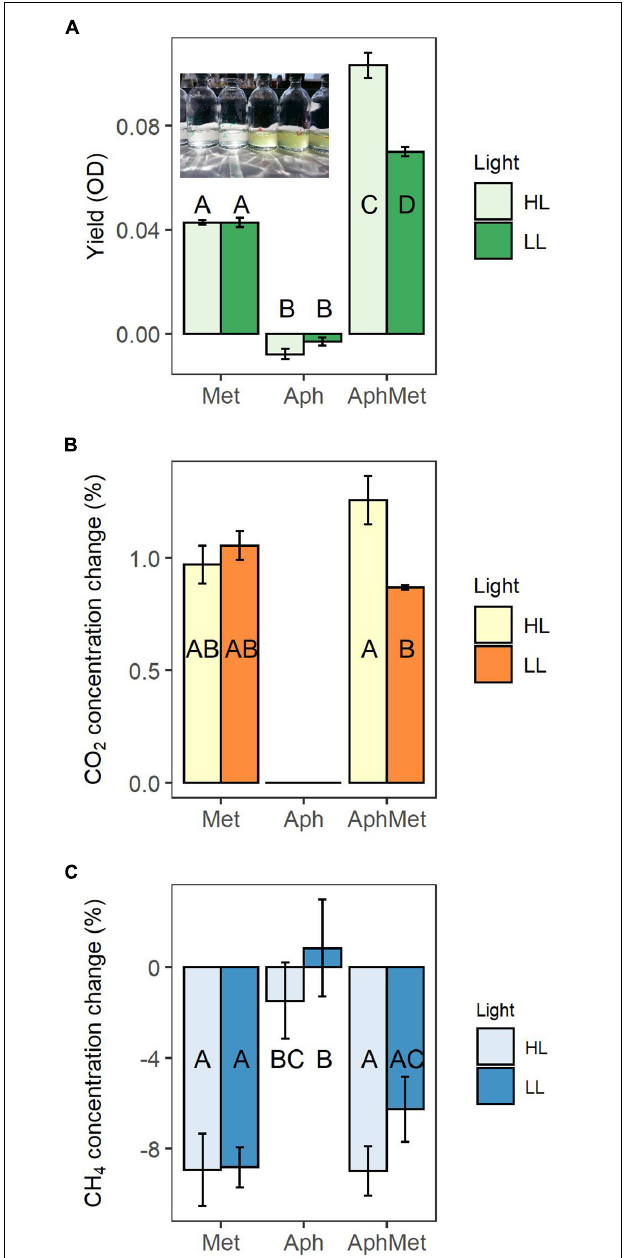
FIGURE 3 | Yield of mono- and co-cultures expressed through optical density (OD), measured at 750 nm (A) , and changes in methane (B) and carbon dioxide (C) concentrations in these incubations. The inset picture represents cultures of Aphanizomenon only (left) and Aphanizomenon with Methylosinus (right) after 12 days. Bars represent the mean ± standard error ( n = 5 for each treatment). Met, Methylosinus ; Aph, Aphanizomenon ; AphMet, mixture of Aphanizomenon and Methylosinus ; HL, high light intensity; LL, low light intensity.